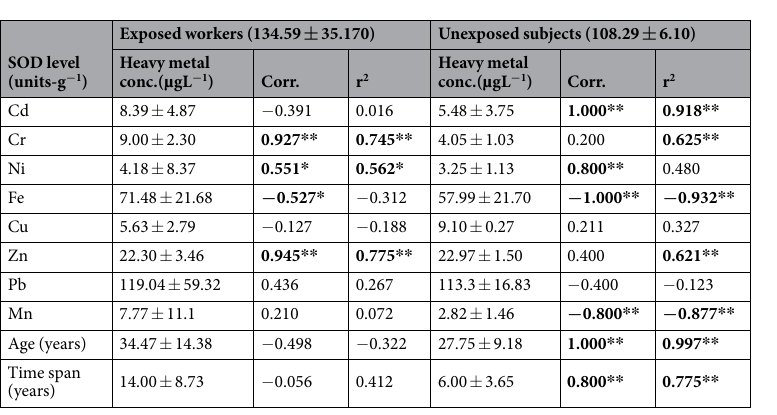
Figure 5. Cumulative Probability Distribution (CPD) of the total HQs in all five leather industries. The results for health risks to the exposed workers were validated using the Monte Carlo simulation based on crystal ball software (Oracle, USA) for 10,000 iterations.